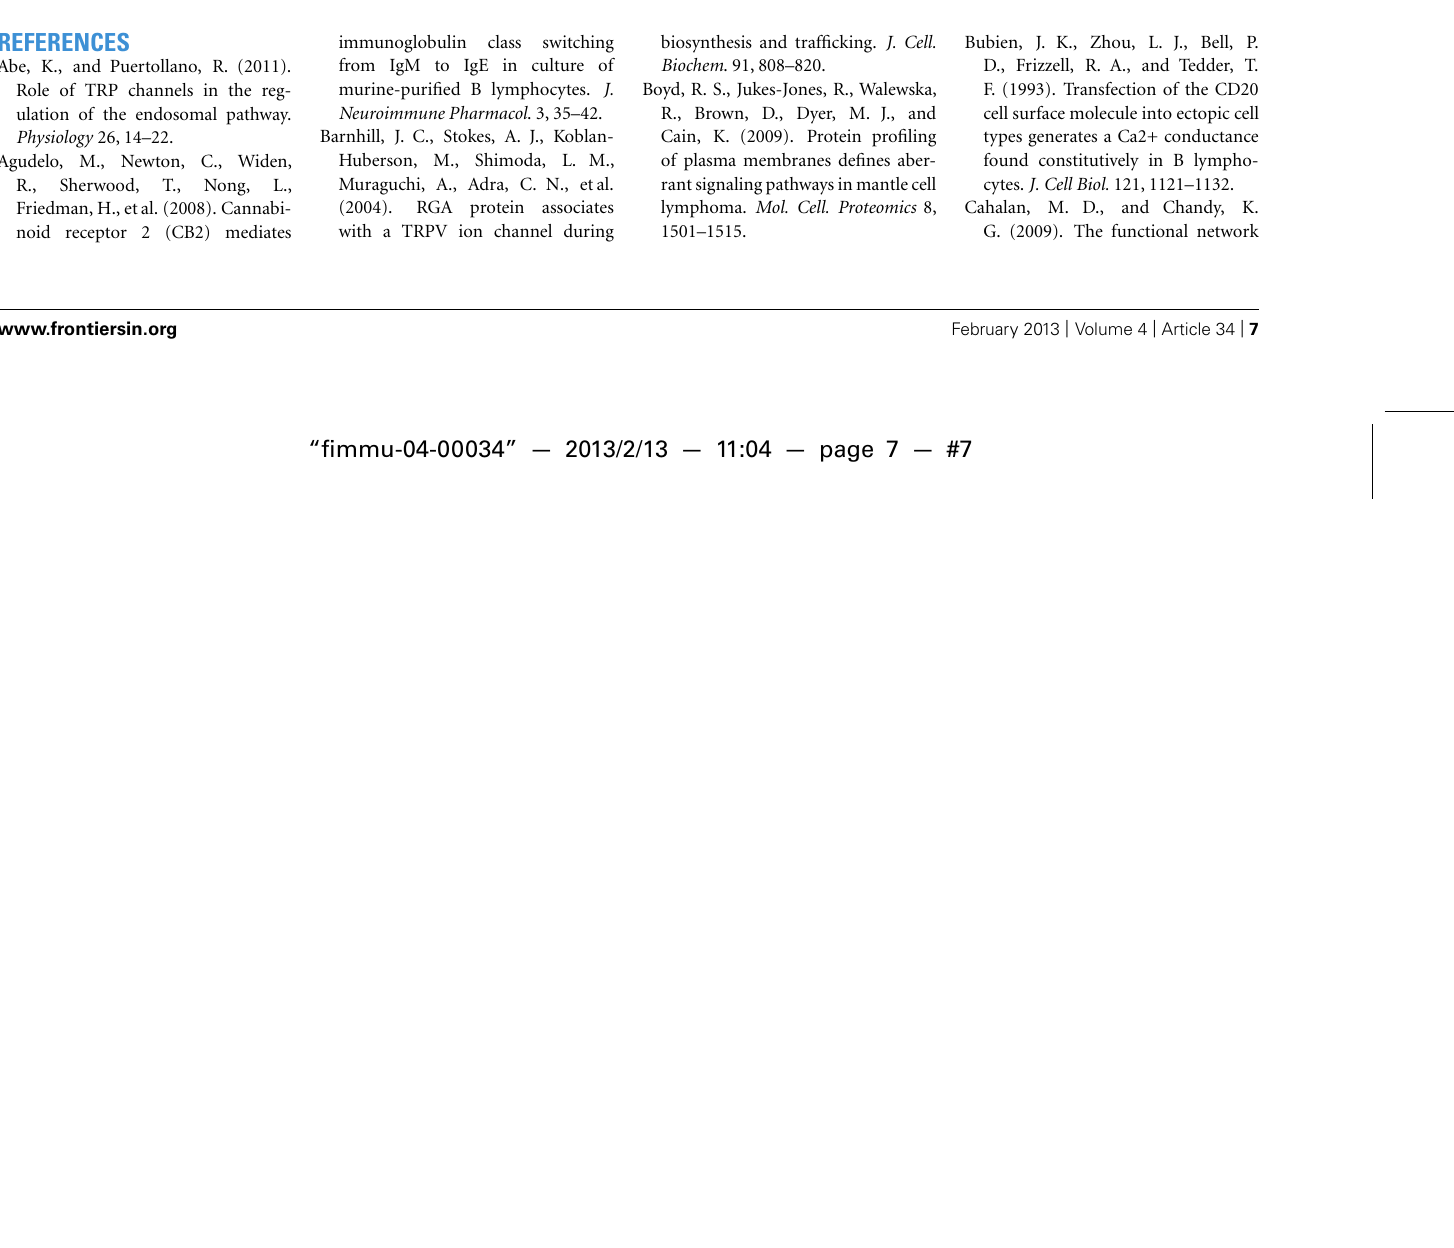
inducing PI(3)K-dependent or independent pathways, may induceTRPV2 translocation and activation, resulting in calcium overload, B cell activation shut-down and induction of pro-apoptotic cell death pathways, in a similar way to